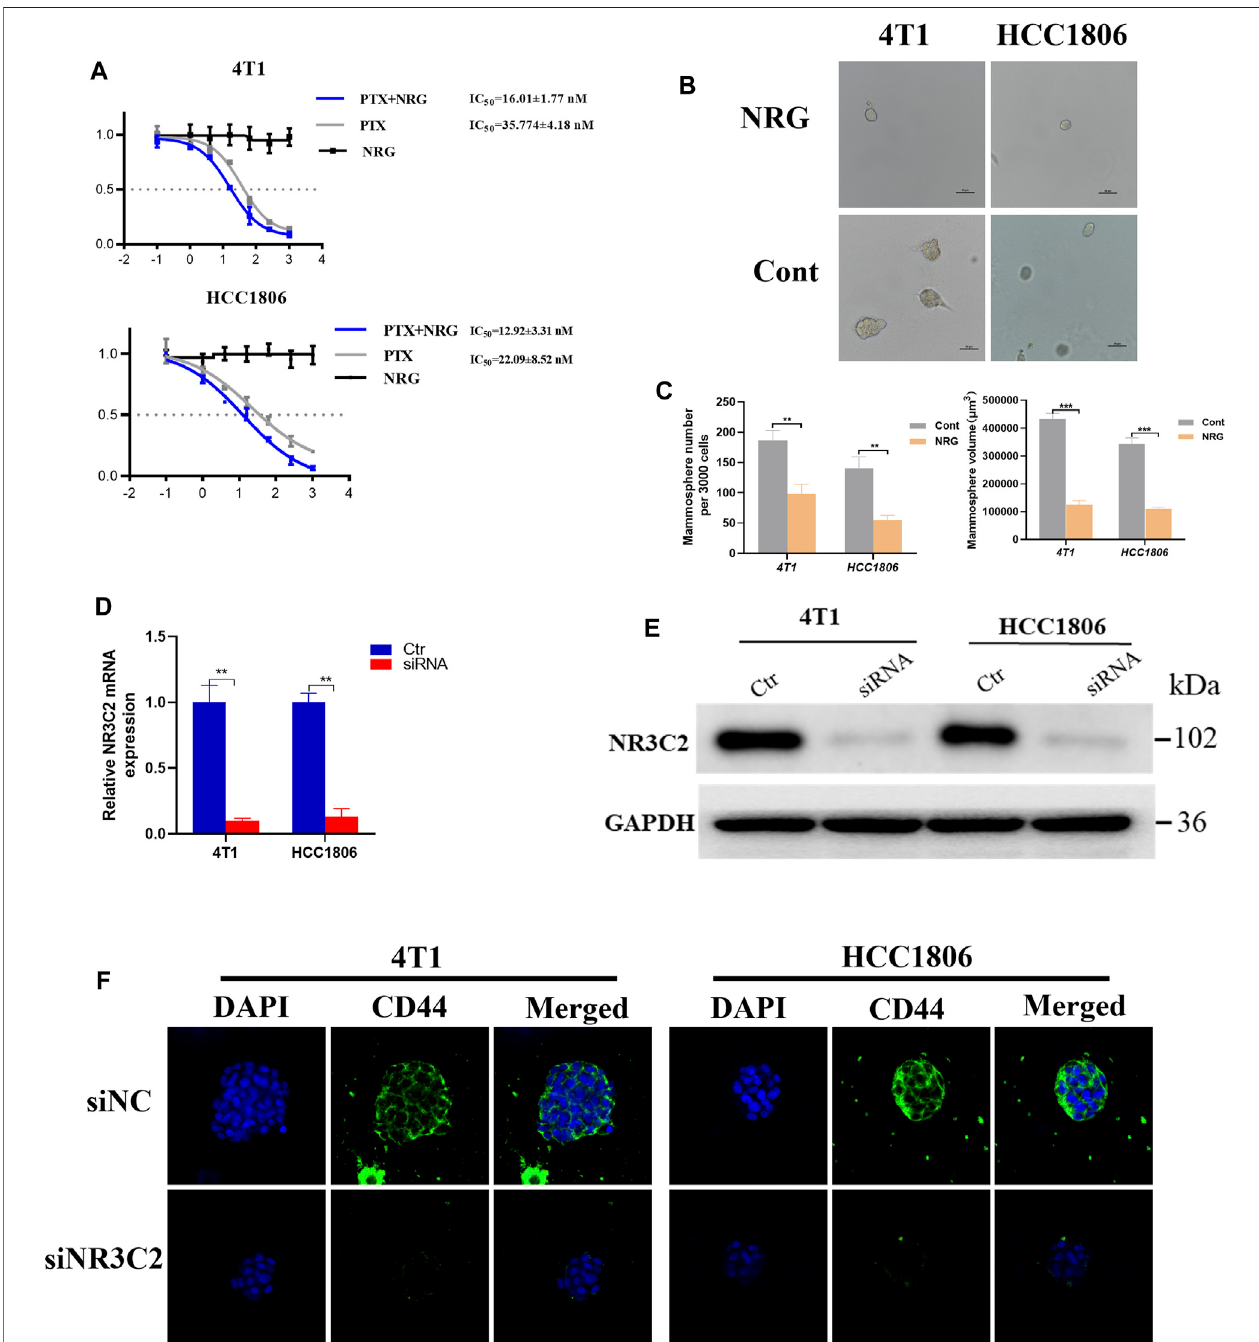
FIGURE8| EffectofnaringeninandNR3C2onstemcellcolonyformationofTNBCcells. (A) 4T1andHCC1806cellsweretreatedwith0,0.1,1,4,16,64,256,and 1024 nM PTX with or without 0, 0.1, 1, 4, 16, 64, 256, and1024 nM naringenin or 0, 0.1, 1, 4, 16, 64, 256, and1024 nM naringenin only for 48 h, respectively. The MTT assay was used to detect the viability of the cells (naringenin compared to control). (B,C) Representative photomicrographs of mammospheres formed by 4T1 and HCC1806 cells treated with naringenin and DMSO (Cont) are displayed. The quanti fi cation of the mammospheres number and size is presented as mean ± SD of three parallel experiments. Statistical analysis was conducted using two-way ANOVA. (D,E) RT-PCR and WB outcomes presented that the knockdown of NR3C2 caused decreasing protein expression levels of the mineralocorticoid receptor (MCR). * p < 0.05, ** p < 0.01, *** p < 0.001 vs control. (F) Representative immuno fl uorescent images for siNC and siNR3C2 TNBC cells for CD44 (green) and DAPI (blue) signals.